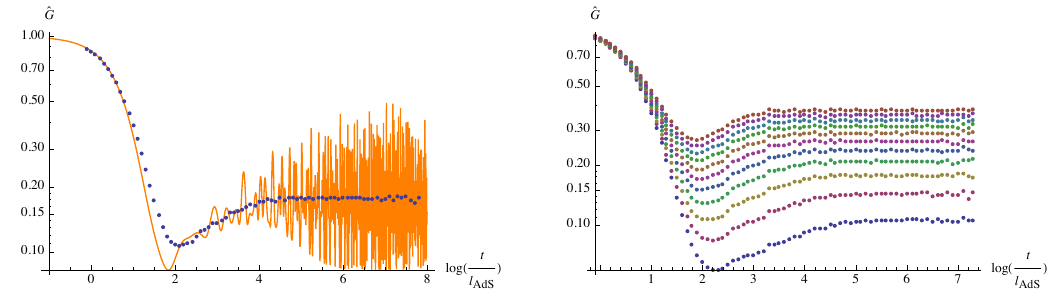
Figure 5 . Left: the continuous orange line represents the regularized two-point function (4.1). The blue dotted line is its progressive time-average. Right: the progressive time-average of (4.1) for (cid:17) = 0 : 05 + 0 : 025 j , j = 0 ; : : : ; 10. Smaller values of (cid:17) correspond to larger N and smaller plateau